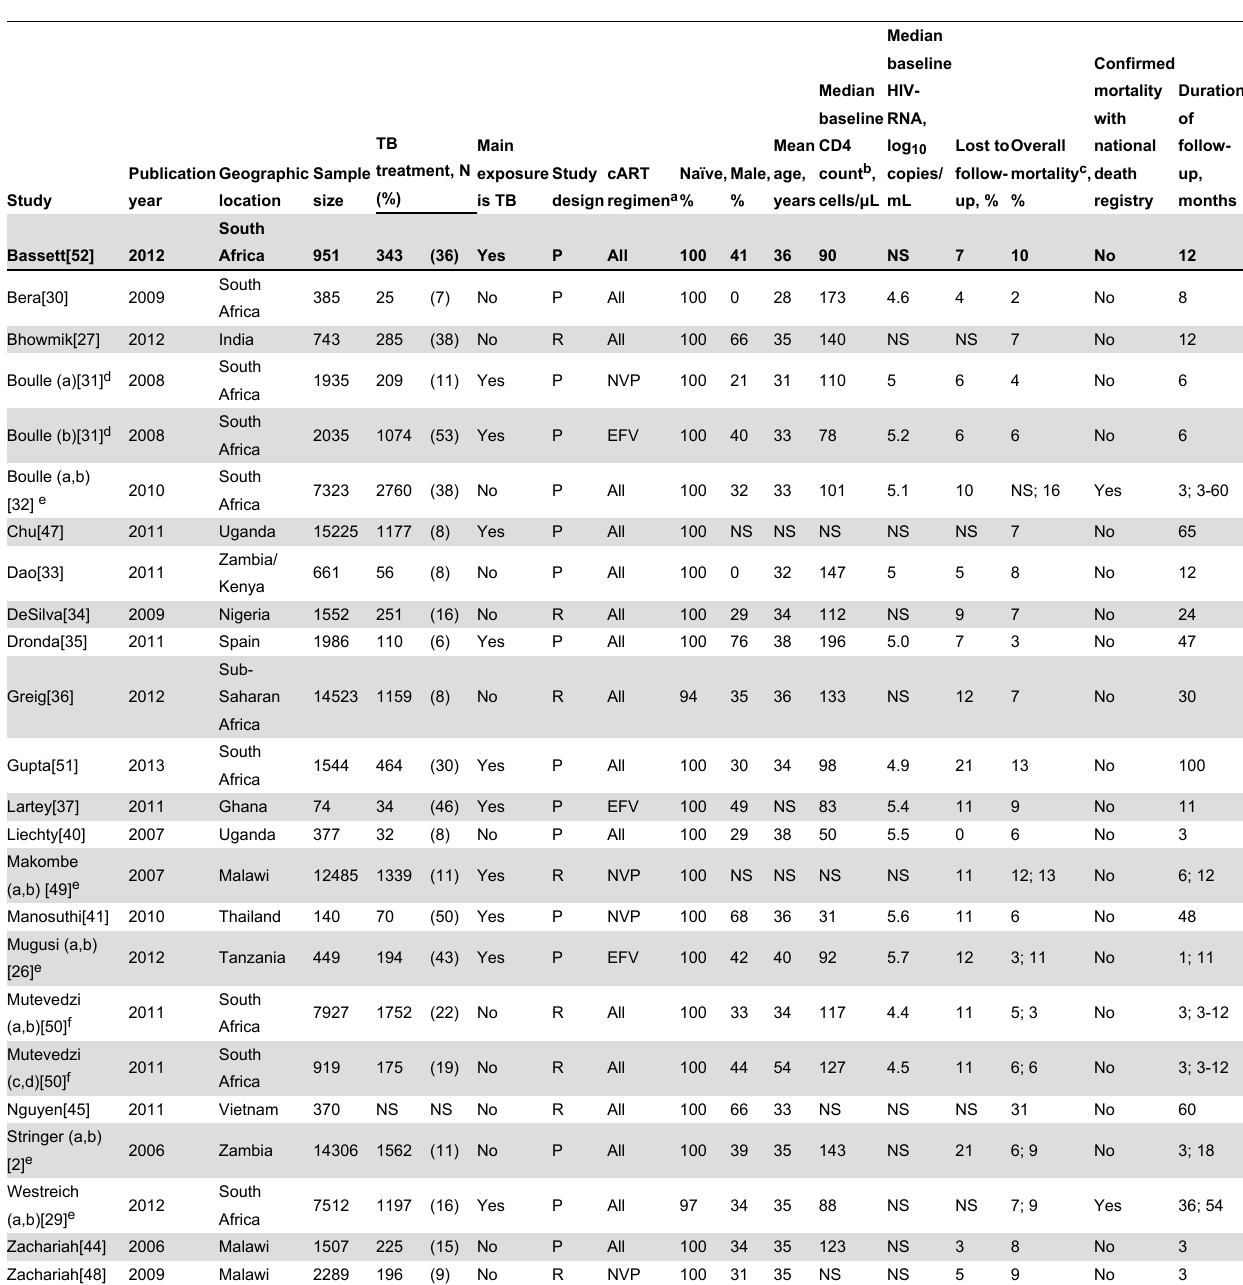
Table 1. Characteristics of 22 studies reporting the effect of TB treatment on mortality after cART initiation among HIV- infected adults.